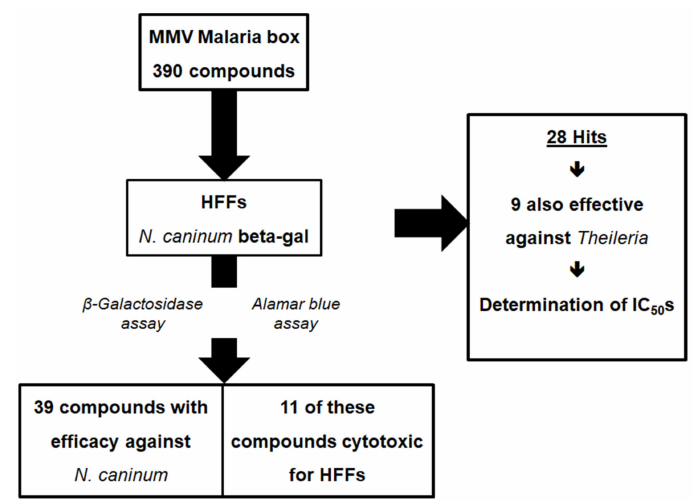
Figure 1. Scheme of the initial screening procedure of 390 Medicines for Malaria Venture (MMV) Malaria Box compounds against Neospora caninum tachyzoites and human foreskin fibroblasts (HFFs).